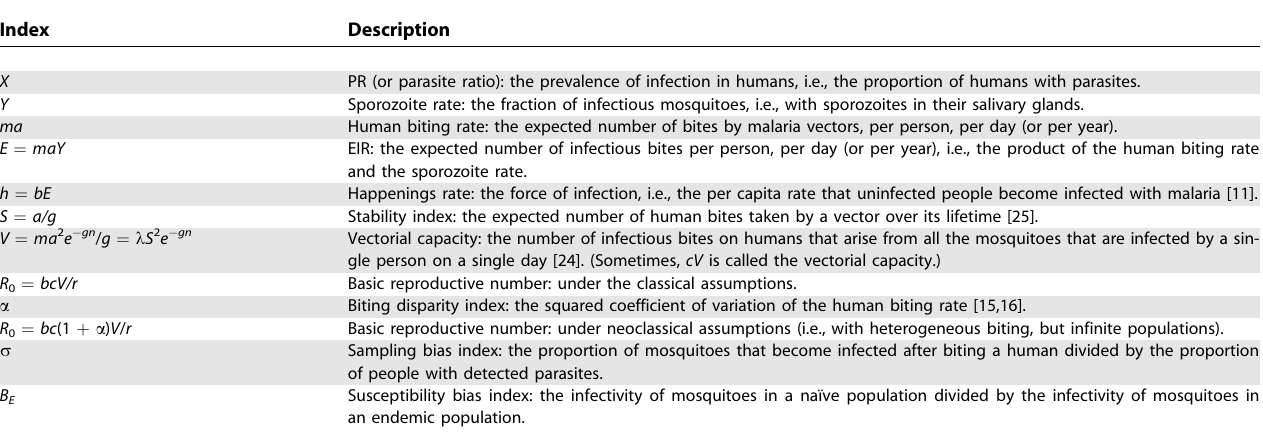
Table 1. Indices of Malaria